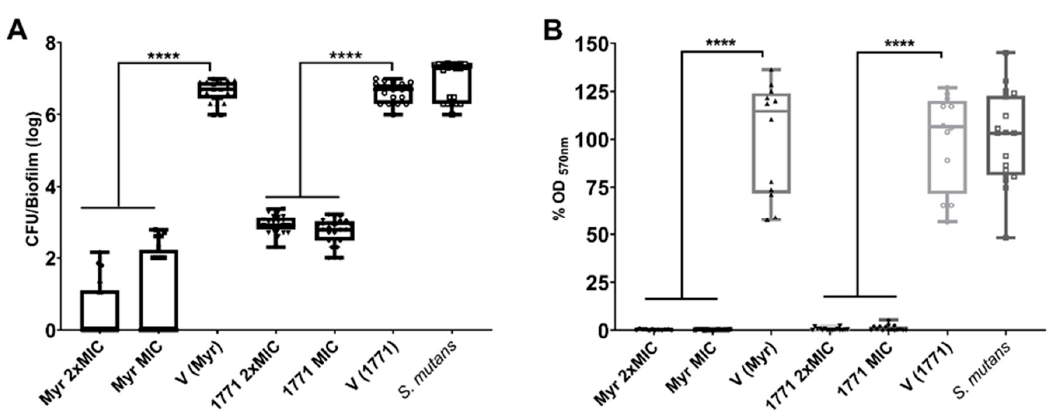
Figure 3. Antibiofilm activity of myricetin and compound 1771 tested at concentrations of minimum inhibitory concentration (MIC) and 2xMIC using the polystyrene microplate model. The S. mutans viable population ( A ) and biomass ( B ) data are shown as the median and interquartile range (n = 12). The two concentrations of the two agents were able to inhibit both viable population and biomass. The vehicle for each agent is shown separately because the experiments were not performed at the same time. S. mutans : growth control group. **** denotes the statistical di ff erence between treatments and V ( p < 0.0001; Kruskal–Wallis test, followed by Dunn’s post-test). Myr: myricetin. 1771: compound 1771. V: vehicle used for each compound.